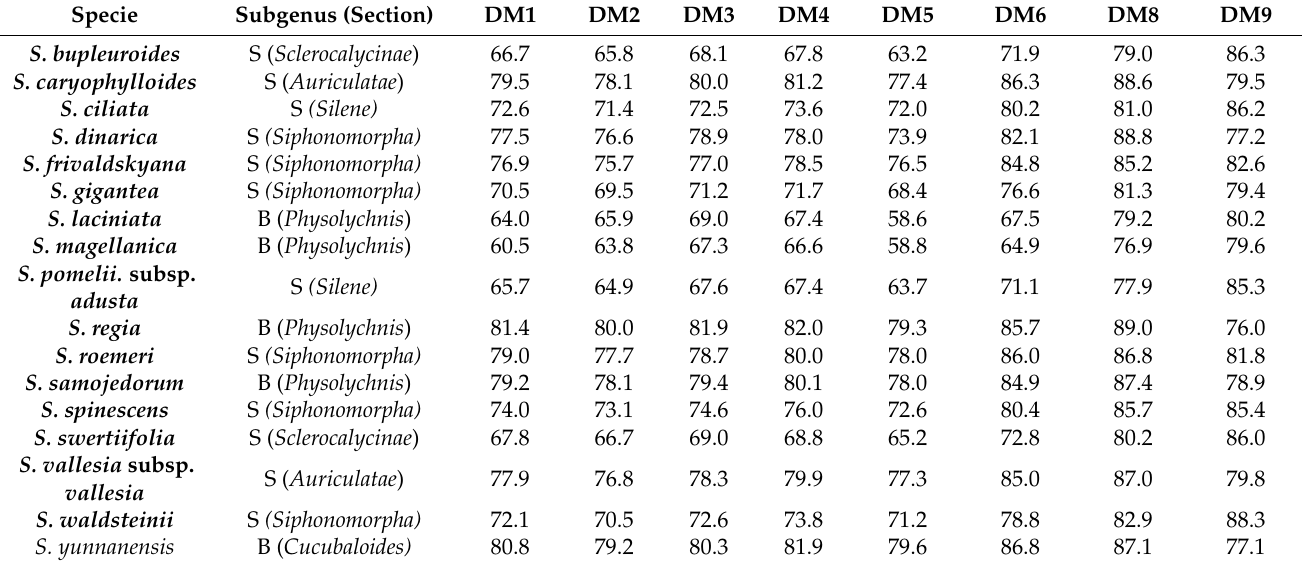
Table A6. Values of the J index for the average silhouettes of each species with seven dorsal models. Species reaching maximum in models DM8 or DM9. In bold: species that did not reach the threshold value of 89.0 for the J index estimated as the mean of 20 seeds. B: corresponds to S. subg. Behenantha ; S: corresponds to S. subg. Silene .